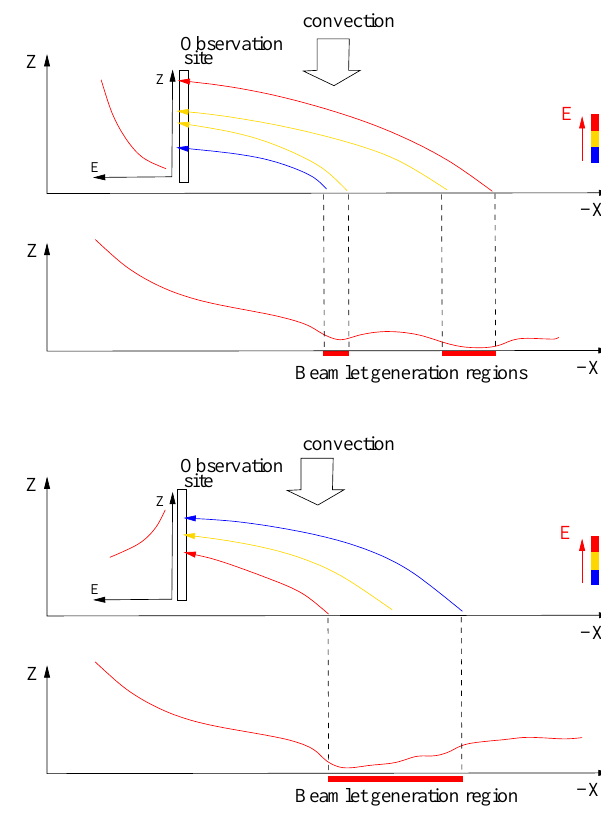
Fig. 13. Two scenario of beamlet energy dispersion. Top panel shows the formation of “normal dispersion” due to both a generally positive dB Z /dX profile and dawn-dusk electric field. The lower panel shows the formation of “inverse dispersion” due to negative dB Z /dX . Such a configuration can be the consequence of new near-Earth X -line